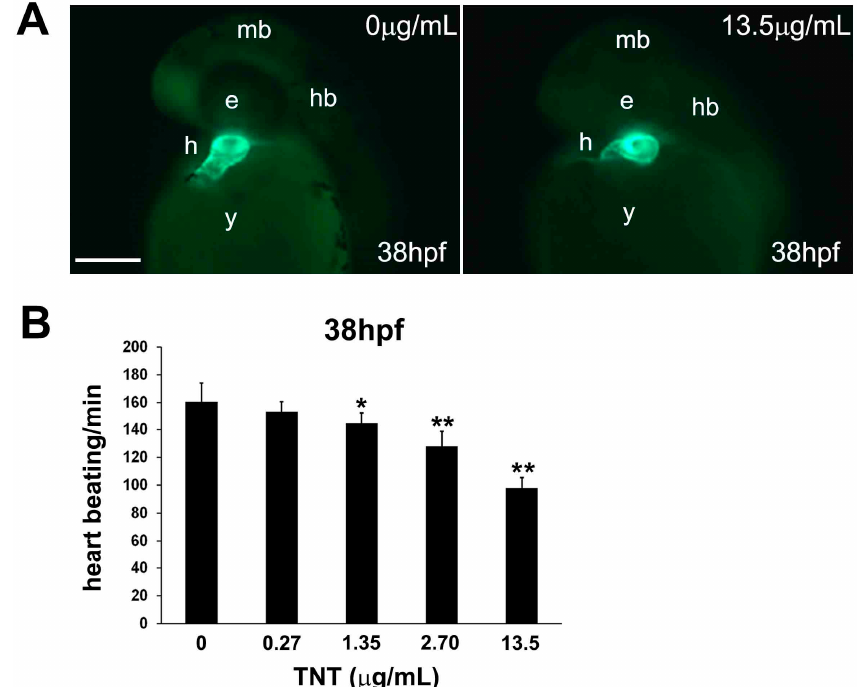
Figure 2. Trinitrotoluene (TNT) in pink water causes defects in heart development and function. ( A ) Tg(cmlc2:EGFP) embryos treated with pink water have myocardiac defects. Embryonic myocardiocytes were imaged at 38 hpf (hours post fertilization) with heads orientated upwards, scale bar 500 µm. Myocardiocytes in the atrium and ventricle were visualized by enhanced green fluorescent protein (EGFP) fluorescence in controls ( a ) and in embryos treated with pink water containing 13.5 µg/mL TNT for 33 h ( b ); ( B ) Heart rate is dose-dependently decreased in 38 hpf embryos by exposure to pink water containing TNT at 0, 0.27, 1.35, 2.70 and 13.5 µg/mL ( n = 20 each). Following exposure to pink water from 5 hpf, Tg(cmlc2:EGFP) embryonic hearts were imaged laterally at 38 hpf using an Axioimager II fluorescence microscope (Carl Zeiss, Overkochen, Germany). * p < 0.05, ** p < 0.001.